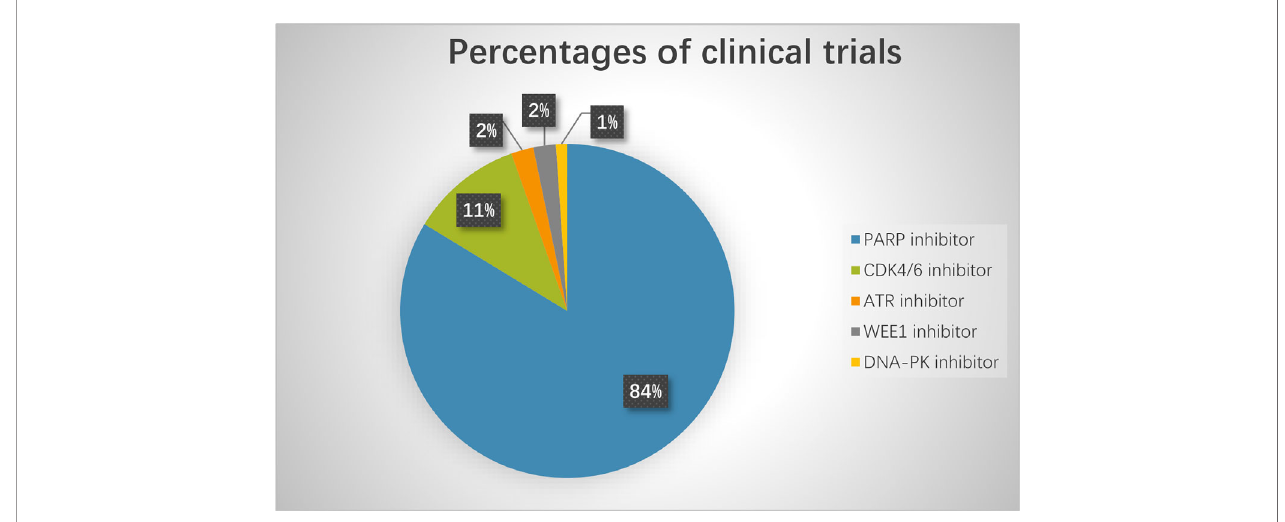
FIGURE 3 | The percentage of clinical trials on combinational therapy with agents targeting DDR and immune checkpoint inhibitors. The total number of the clinical trials is